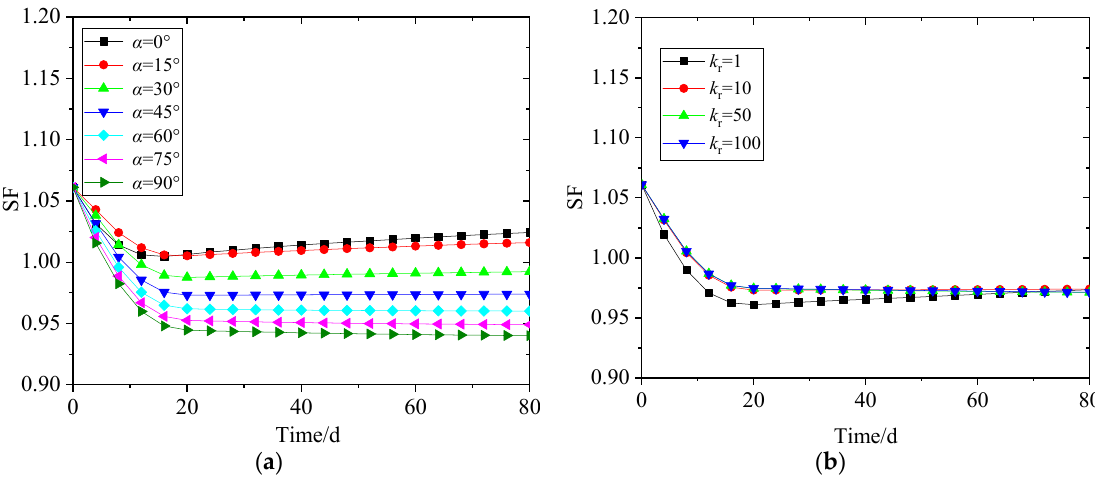
Figure 12. SF of clay slope under different k r and α values. ( a ) k r = 10 . ( b ) α = 45°.